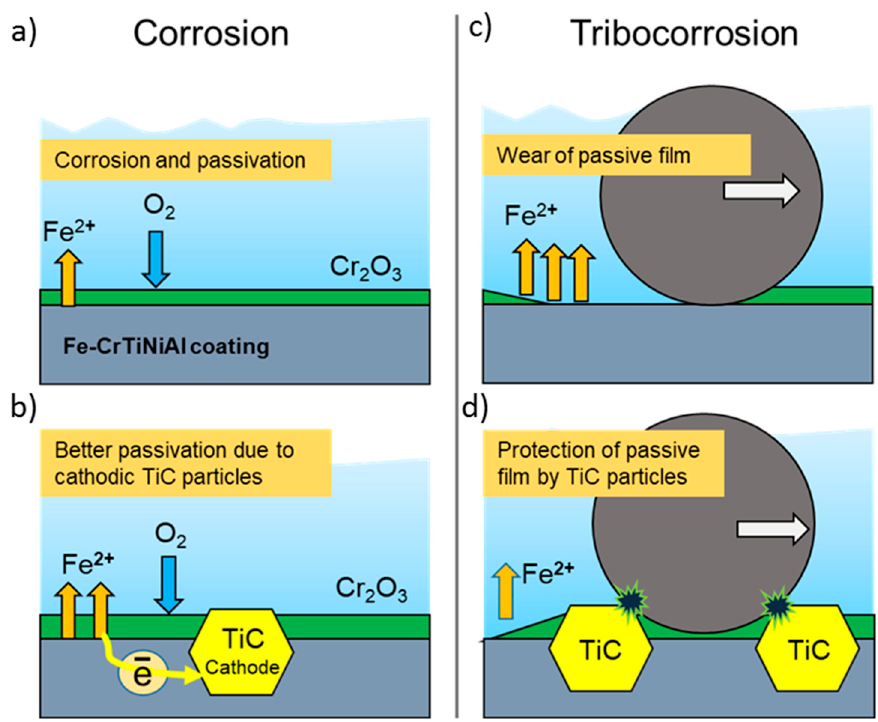
Figure 13. Scheme of TiC particles’ effect on the corrosion behavior of the coatings under station- ary ( a , c ) and wear conditions ( b , d